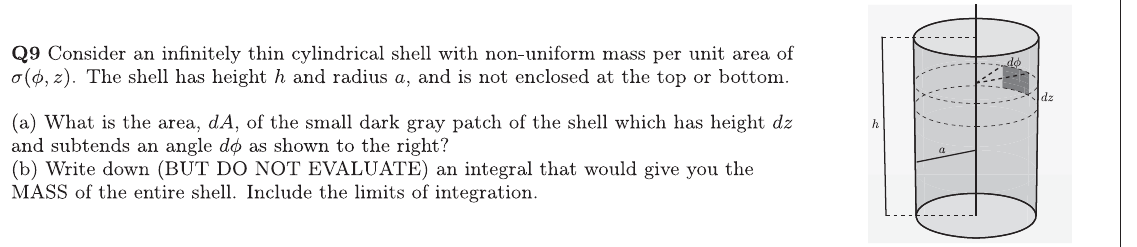
FIG. 1. Certain topic-scale learning goals are evaluated by the CCMI questions. The sample question appears on the CCMI pre- and post tests; vector calculus is a prerequisite for CM 1. This question constitutes 9% of the total post-test